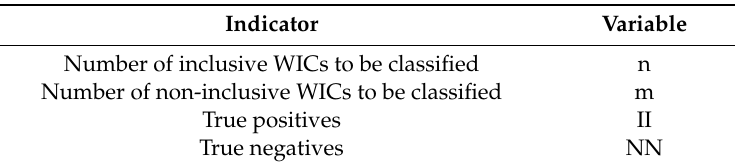
Table 9. Calculating performance.